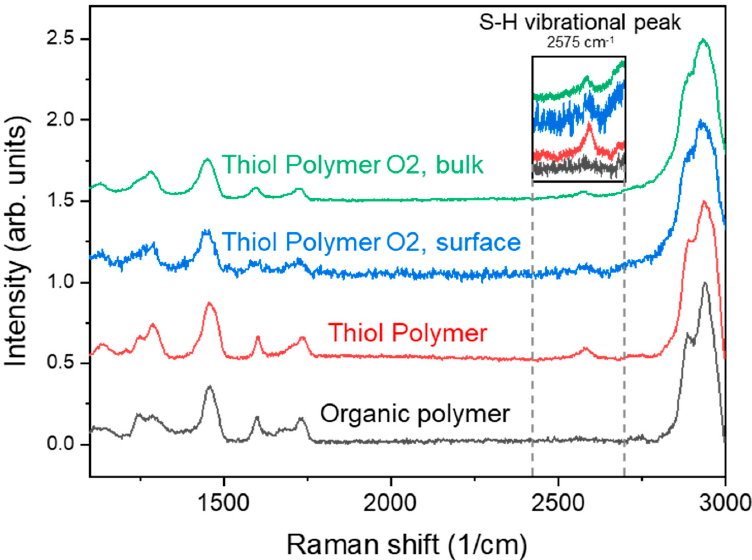
Figure 4. Raman scattering of the polymer samples. The graph shows the signal obtained on a non-thiol polymer (“Biopolymer”, an organic polymer, used as control) (black line). The red line shows the signal from a thiol polymer film. The blue and green signals correspond to a film etched using an O 2 plasma, and measured at the surface and the bulk respectively. The inset shows a detail of the peak at 2575cm − 1 , which corresponds to the R–SH vibrational mode of the thiol groups.